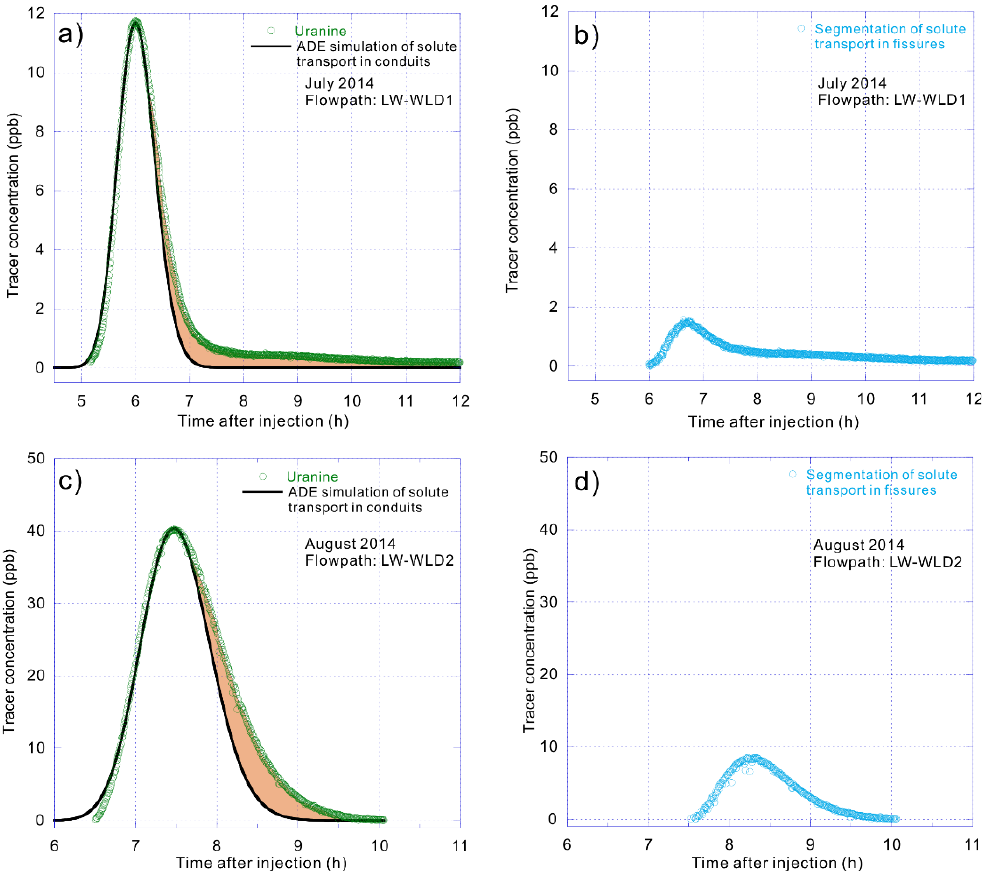
Figure 4. Breakthrough curves, fitting curves of solute transport in conduit flow and segmentations of solute transport in fissure flow of LW – WLD (Longwan-Wulongdong) . ( a ) Breakthrough curve of